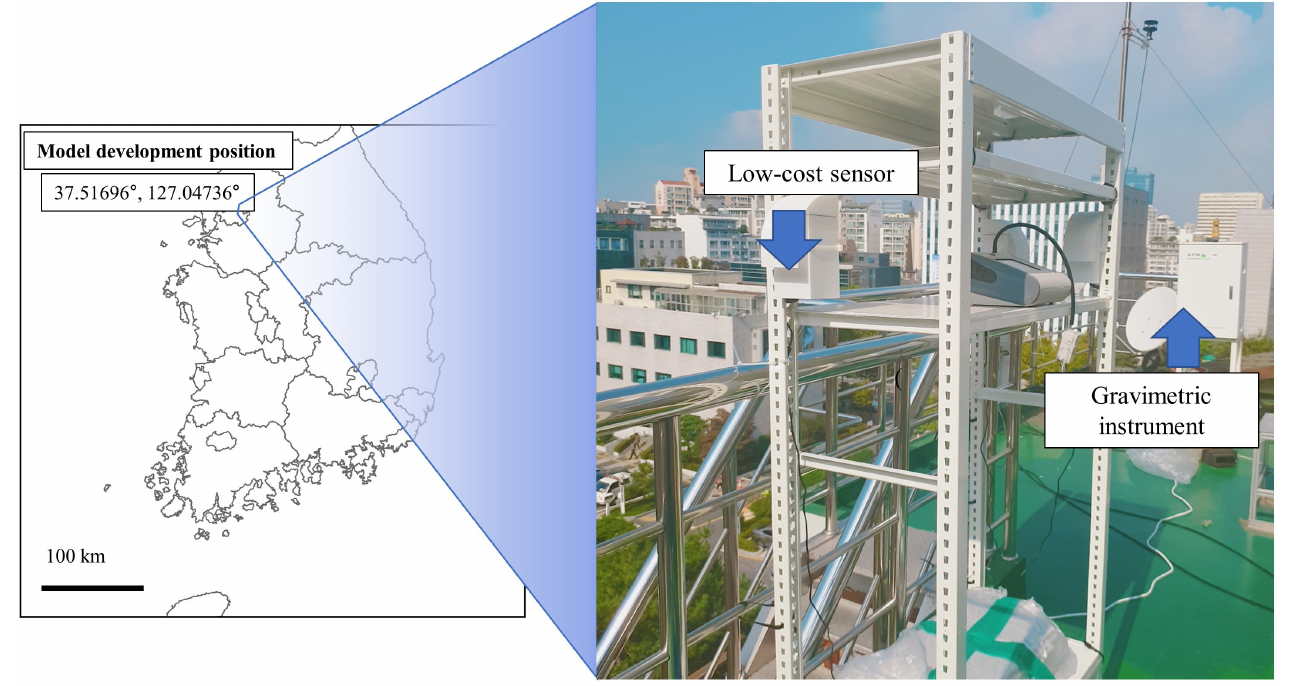
Figure 2. Measurement position and field test setup.